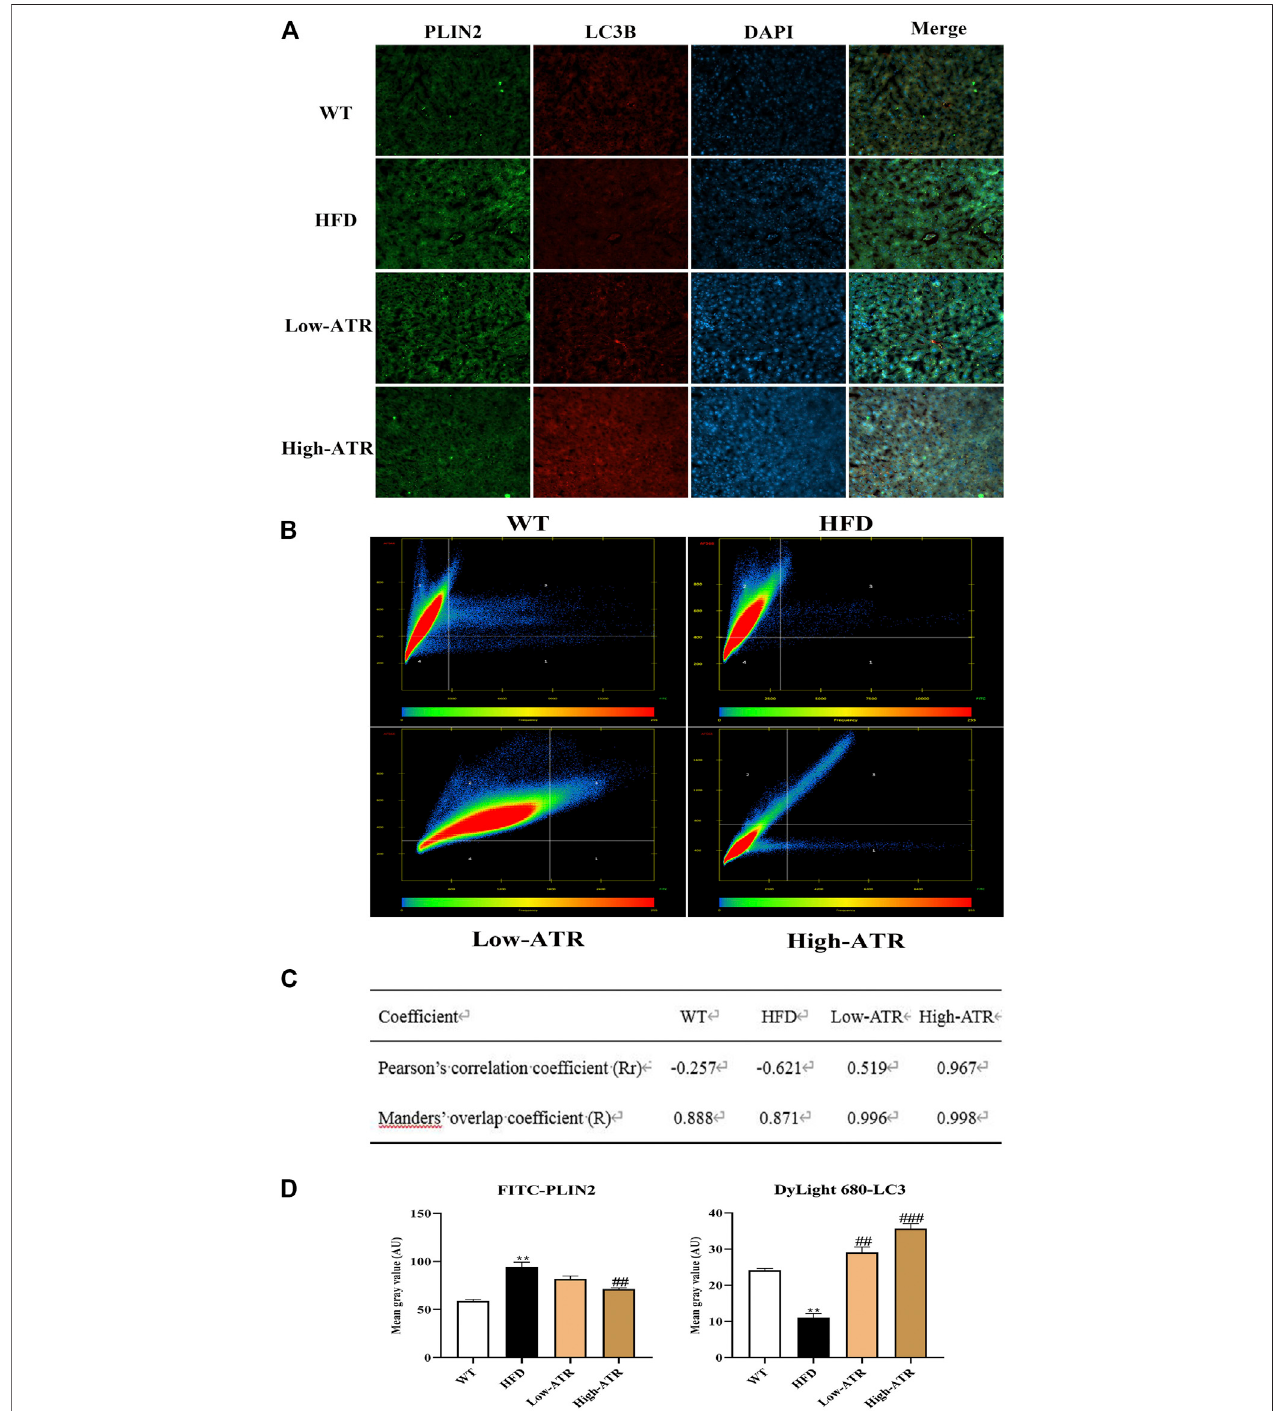
FIGURE 5 | The colocation of LC3B protein with perilipin 2 protein. (A) Representative confocal images of colocalization of Cy3-stained LC3B protein with FITC- stainedPLIN2protein. (B) The scatter plotobtained from Colocalization modules ofZENsoftware.Quadrant 1representspixels thathave high green intensities and low redintensities.Quadrant2representspixelsthathavehighredintensitiesandlowgreenintensities.Quadrant3representsthecolocalizedpixelswithhighintensitylevels in both red and green. Quadrant 4representsthe background pixels with lowintensity levels in both red and green. (C) Results ofcoef fi cients calculations;valueof Rrexpressedfrom − 1.0to+1.0,valuefrom0.5to1.0indicatingcolocalization,andvaluefrom − 1.0to0.5indicatingabsenceofcolocalization;valueofRexpressedfrom 0 to 1.0, the value indicates an actual overlap of the signals, is considered to represent the true degree of colocalization. (D) Optical density analysis of fl uorescence intensity. Data are expressed as mean ± SD ( n (cid:2) 8). * p < 0.05, ** p < 0.01, *** p < 0.001 (* represents HFD groups compared with the WT group). # p < 0.05, ## p < 0.01, ### p < 0.001 ( # represents ATR treatments compared with the HFD group). WT (cid:2) control group, and HFD (cid:2) high-fat diet group.